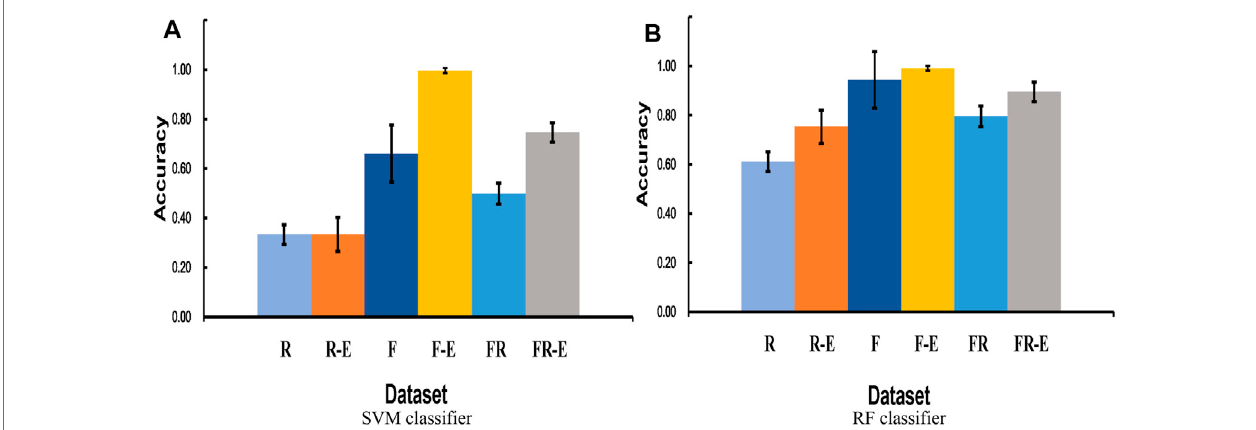
FIGURE 8 | (A) compares the cross-validation accuracy across different datasets by SVM-based classi fi cation, and (B) compares the cross-validation accuracy acrossdifferent datasets by RF-based classi fi cation. R and F representthatonly real dataand fake dataare used,respectively. R-E and F-E representthe realand fake datasetsafterequalization,respectively. FR representsamixturedatasetwithequalamountsofrealdataandfakedata. FR-E representsamixtureofequalizeddatasets containing both real and fake data.